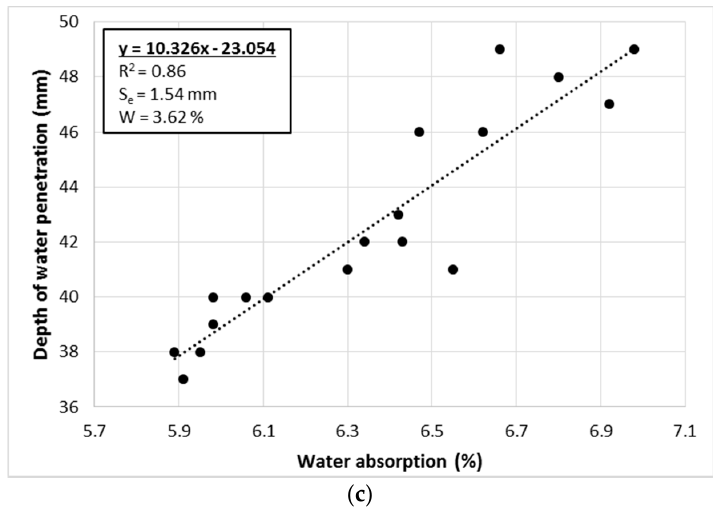
Figure 4. Relations between physical features of concrete with RGA: ( a ) bulk density—water absorption; ( b ) bulk density—water resistance; ( c ) water absorption—water resistance; (water resistance represented in this case by the depth of water penetration); designation of abbreviations are placed in the text.